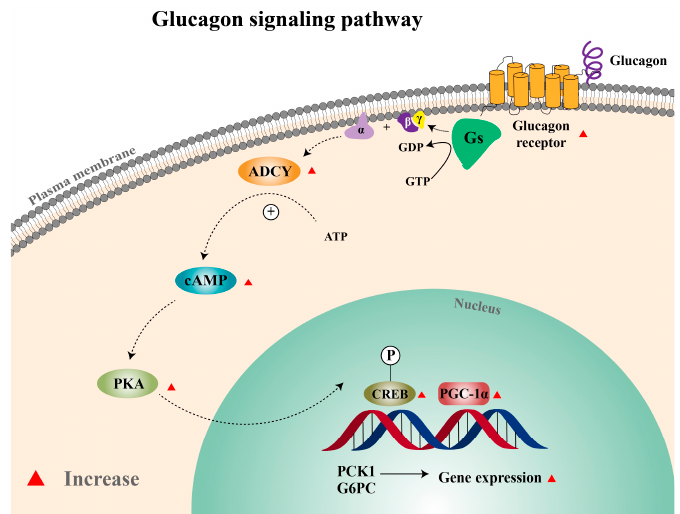
Figure 9. Glucagon signaling pathway in the Japanese fl ounder. Gs, guanine nucleotide-binding protein Gs; GDP, guanine dinucleotide phosphate; GTP, guanine trinucleotide phosphate; ADCY, adenylate cyclase; ATP, adenosine triphosphate; cAMP, cyclic adenosine monophosphate; PKA, protein kinase A; CREB, cAMP response element-binding protein; PGC-1 α , peroxisome proliferator-activated receptor- γ coactivator 1- α ; PCK1, phosphoenolpyruvate carboxykinase 1; G6PC, glucose-6-phosphatase.